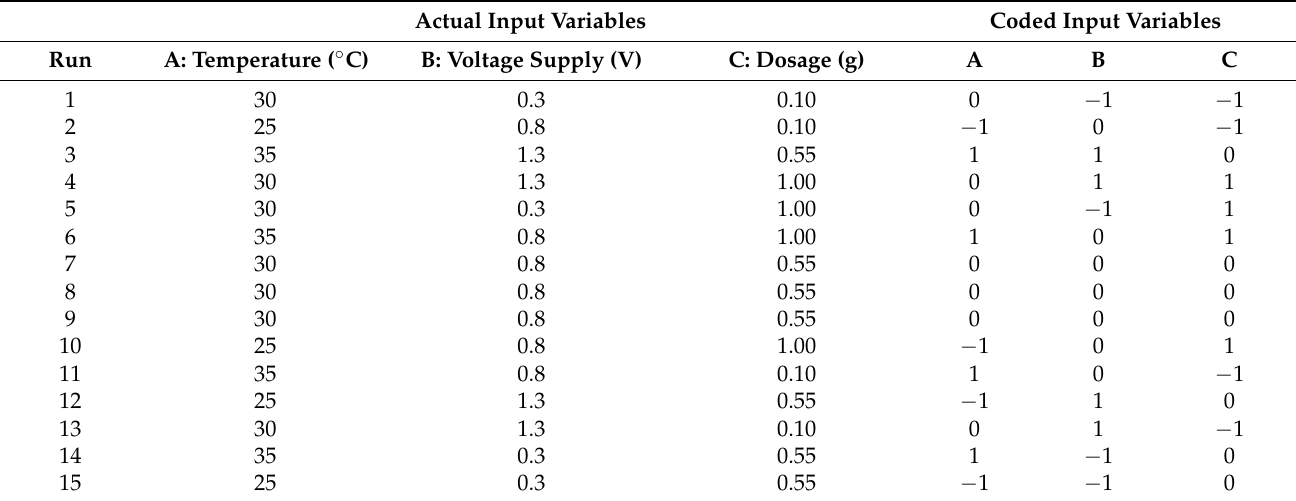
Table 11. Design matrix for the Box–Behnken design